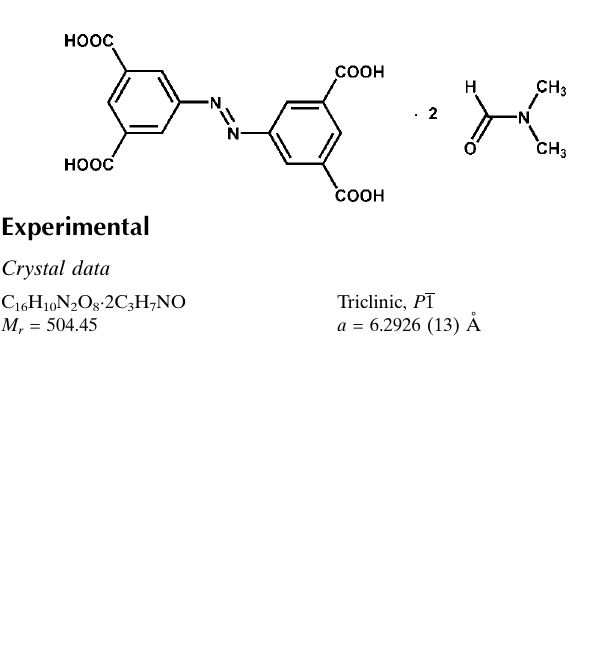
For general background information on the applications of